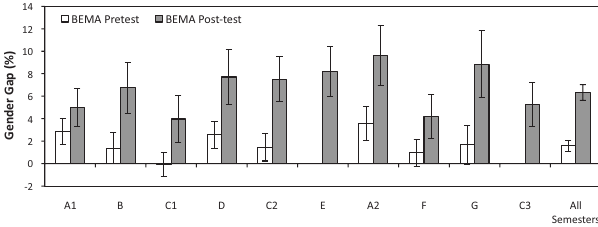
FIG. 3. FMCE and BEMA gender gaps (cid:1)(cid:5) S (cid:6) M − (cid:5) S (cid:6) F (cid:2) by semes- ter. The gender gaps for each semester are shown above (cid:1) N =1487 (cid:2) for only those students who took both the FMCE (cid:1) in the first-semester course (cid:2) and the BEMA (cid:1) in the second-semester course (cid:2) . The error bars represent the standard errors of the